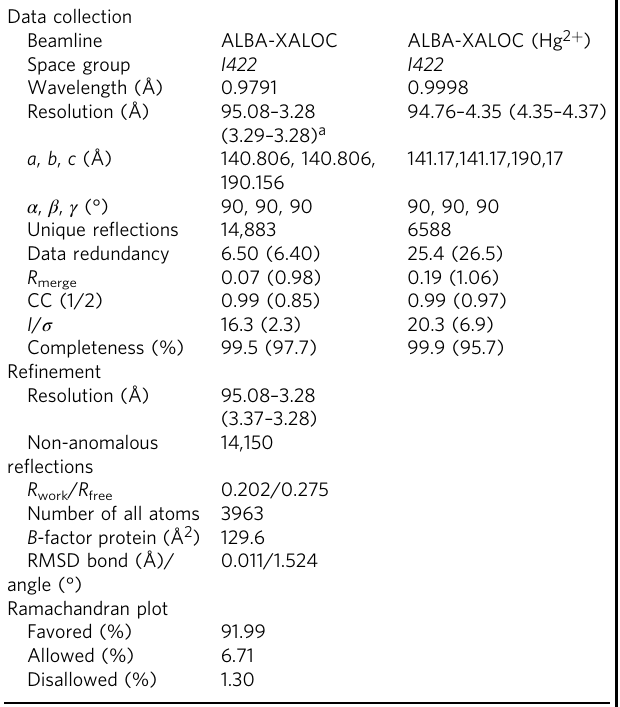
Table 1 Data collection and structure re fi nement statistics Data collection